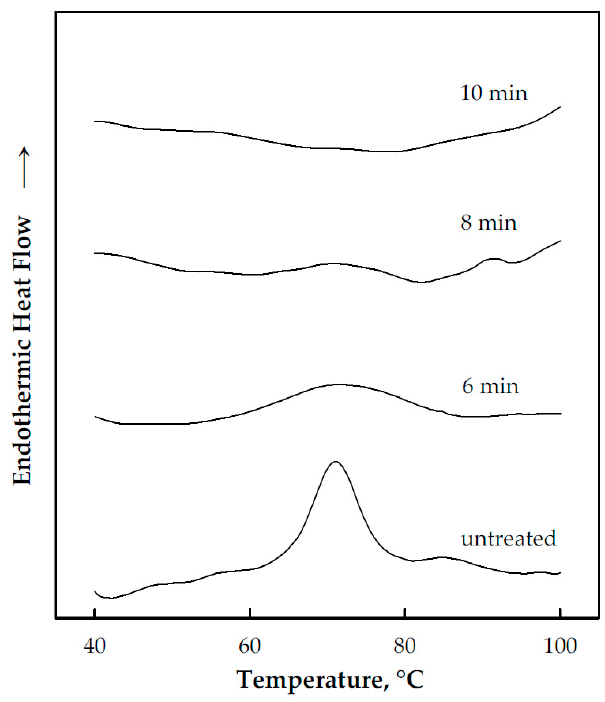
Figure 6. DSC curves at different cooking times at the 85 °C cooking temperature.